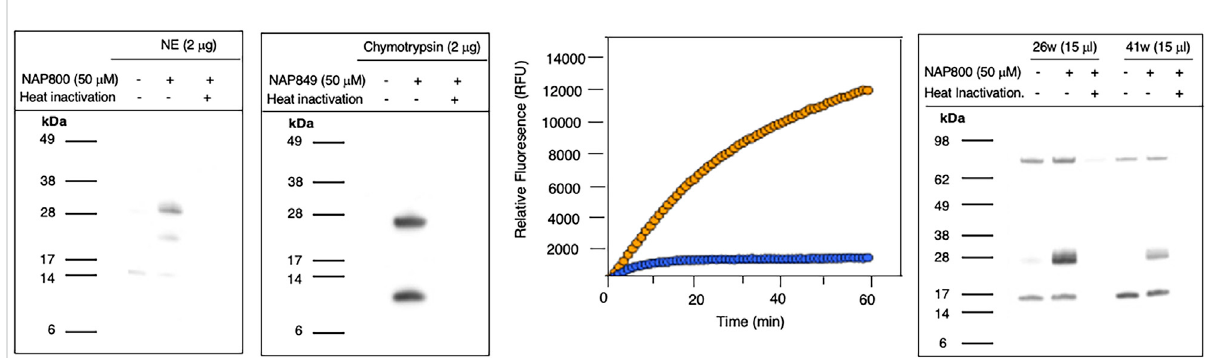
FIGURE 7 ActivityBasedPro fi lingofserineproteasesbypeptideN-Alkylglycinecarbamates. (A,B) recordtheresultsfortheincubationofNEwithNAP800 and chymotrypsin with NAP849. NE and Chymotrypsin were treated (±) with NAP800 and NAP849, respectively (± pre-heat inactivation at 95 ° C, for 10 min),for30 min,at37 ° C. (C) DeterminationofNElevelsinCFsamplesusing fl uorogenicsubstrateassay.NEassayswerecarriedoutinPBS,pH7.4, at37 ° C.CFSol(sample26w)wasusedata fi nalconcentrationof2.5%(v/v),andthelevelofNEcontainedthereinwasmeasuredusingSuccinyl- Ala-Ala-Pro-Val-NHMec(50 μ M),intheabsence( – o – )andpresence( – o – )ofNAP800(50 μ M). (D) Activitybasedpro fi lingofCFSolusingNAP800. CF Sol samples 26w and 41w were treated (+) with 50 μ M NAP800 (+ pre-heat inactivation at 95 ° C, for 10 min), for 30 min, at 37 ° C.